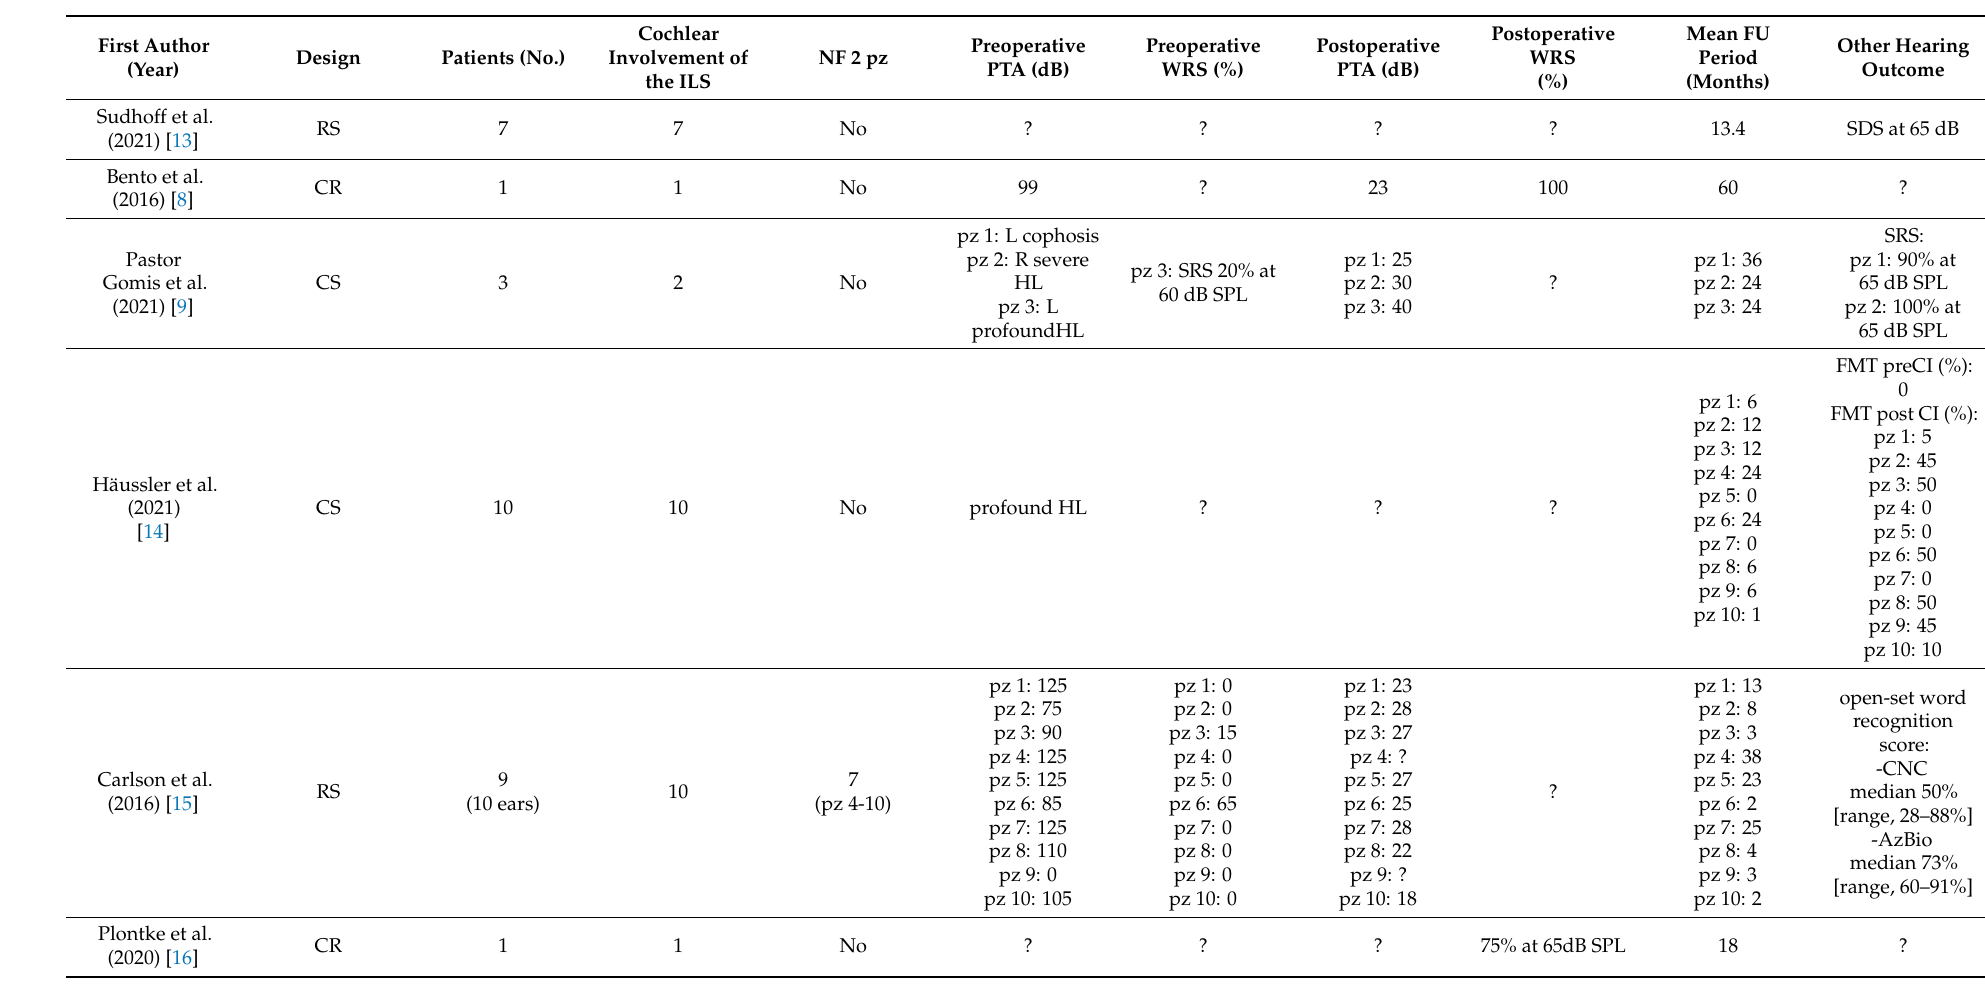
Table 1. Summary of the studies included in our review (all data concern the implanted